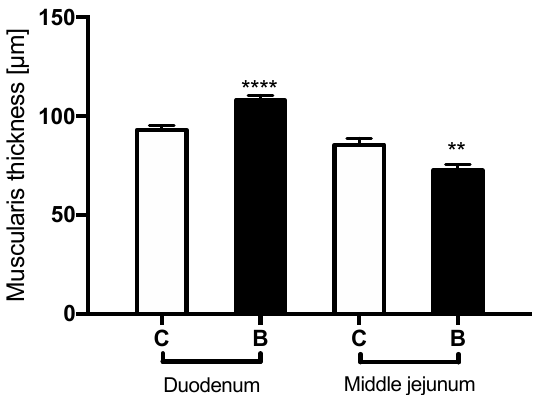
Figure 1. The thickness of the muscularis mucosa muscle layer ( µ m) in the duodenum and middle jejunum of control (C) and sodium-butyrate-treated piglets (B). Values are given as means ± SD; * indicates statistical differences between groups. In the duodenum, sodium butyrate led to a significant increase in the thickness of the muscle layer (**** p < 0.0001). On the contrary, a significant reduction in the muscularis thickness was observed in the middle jejunum after sodium butyrate administration (** p = 0.0023).